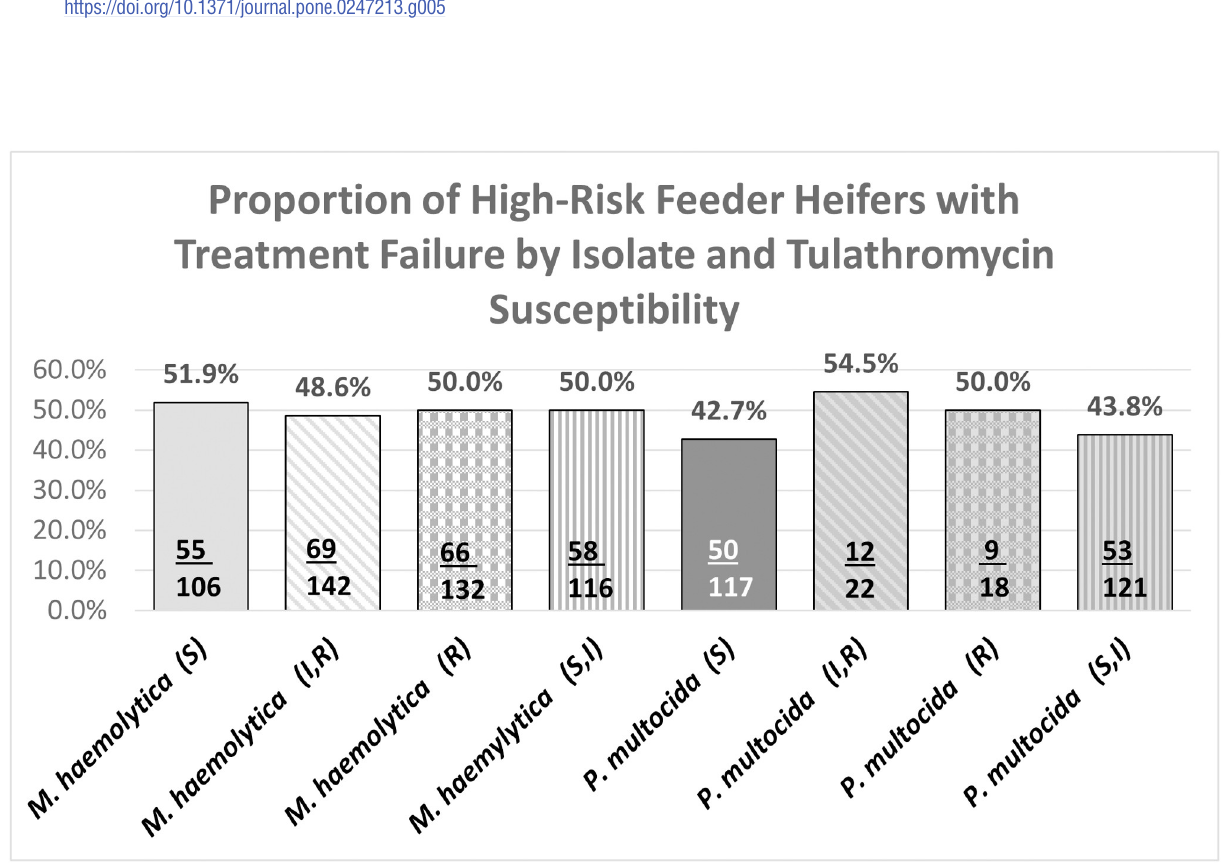
Fig 6. High-risk feeder heifer BRD treatment failure by bacterial isolate and tulathrymycin susceptibility.